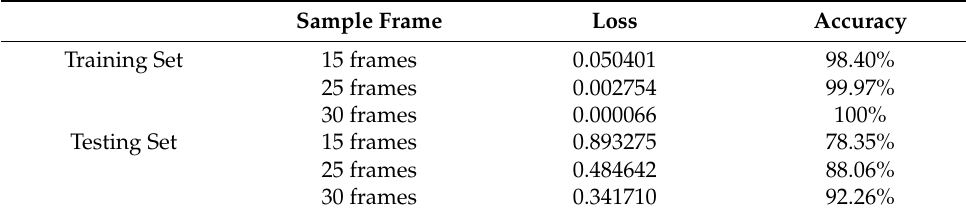
Table 9. Effects of sample frame number on